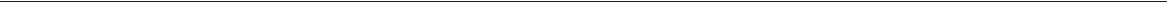
Fig. 3 USP52 opposes ASF1A polyubiquitination. a In vitro deubiquitination assays with HeLa cells-puri fi ed Myc-USP52 (1, 2, and 3 μ g for each lane) and HA-Ub-conjugated FLAG-ASF1A with high salt and detergent buffer. b HeLa cells stably expressing FLAG-ASF1A were co-transfected with control siRNA or USP52 siRNA together with HA-Ub as indicated. Cellular extracts were prepared for co-immunoprecipitation assays with anti-FLAG followed by IB with anti-HA. c HeLa cells stably expressing FLAG-ASF1A were co-transfected with HA-Ub and different amounts of Myc-USP52. Cellular extracts were prepared for co-immunoprecipitation assays with anti-FLAG followed by IB with anti-HA. d HeLa cells were transfected with different amounts of Myc- USP52 and cellular extracts were prepared for co-immunoprecipitation assays with anti-ASF1A followed by IB with antibody against ubiquitin. e Cellular extracts from HeLa cells expressing HA-Ub/K48-only and different amounts of Myc-USP52 were prepared for co-immunoprecipitation assays with anti- ASF1A followed by IB with anti-HA. f In vitro deubiquitination assays with HeLa cells-puri fi ed FLAG-tagged ASF1A-Ub/K48-only and different amounts of Myc-USP52 (1, 2, and 3 μ g for each lane) with high salt and detergent buffer. g HeLa cells stably expressing wild-type ASF1A (ASF1A/wt) or different K to R mutants were co-transfected with HA-Ub and control vector or Myc-USP52 as indicated. Cellular extracts were prepared for co-immunoprecipitation assays with anti-FLAG followed by IB with anti-HA. h Mass spectrometry analysis of ASF1A ubiquitin conjugation sites. HeLa cells stably expressing FLAG- ASF1A were co-transfected with HA-Ub and USP52 siRNA. Cellular extracts were collected and sequentially puri fi ed with anti-FLAG af fi nity gel and